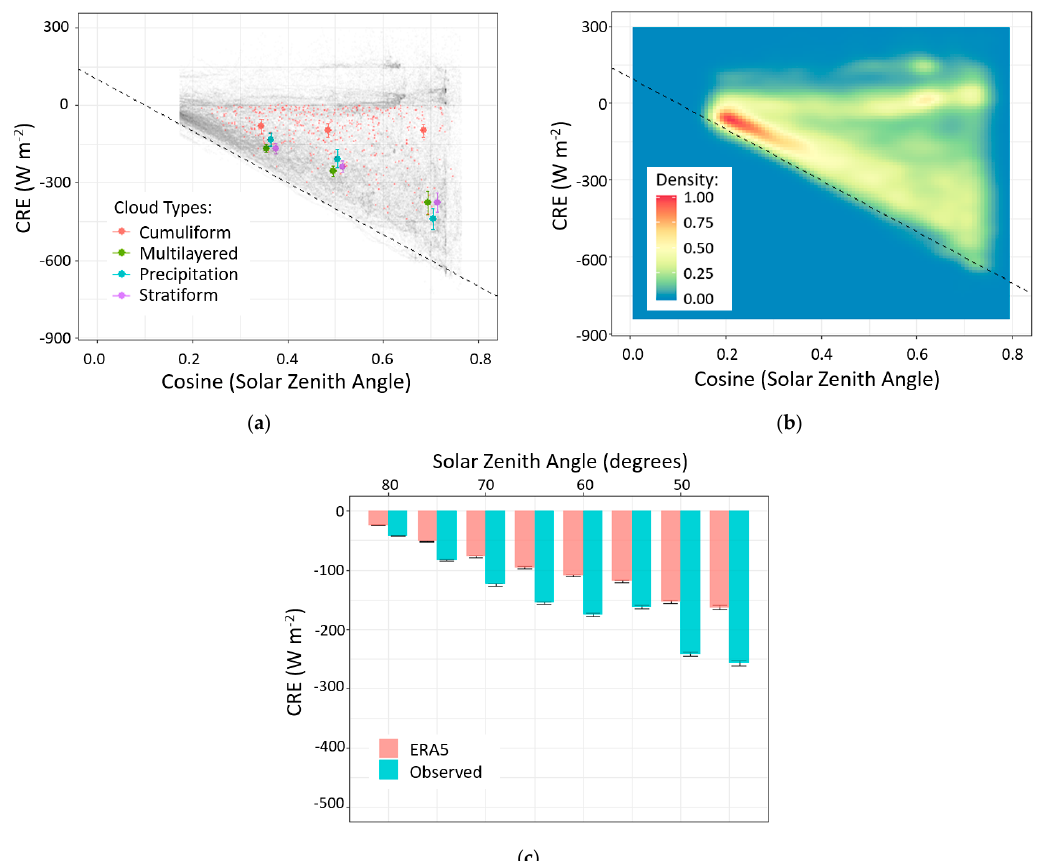
Figure 12. Net cloud radiative effect (CRE) from all observations as a function of the cosine of solar zenith angle as ( a ) individual points (grey filled dots) and ( b ) coloured by occurrence frequency (density) scaled to 0–1 (blue to yellow to red). In ( a ) small red filled dots show 3-hourly average values from ERA5; large filled dots are averages coloured according to cloud type inferred from camera images at three solar zenith angle: 69°, 60° and 46° (values are offset either side of the centre of each angle for clarity; vertical bars span ±2 standard errors in the mean): cumuliform clouds (orange), multilayered clouds (green), clouds causing surface precipitation (blue), and stratiform clouds (purple). In ( a ) and ( b ) the dashed line shows the approximate lower limit of measured net CRE from Minnett [54] . The observed 1-min CRE values are shown in half-transparent grey dots and 3-hourly averaged ERA5 data (red dots). ( c ) Histograms of averaged net CRE as a function of solar zenith angle from all 1-min observations (blue) and averaged net CRE from 1-min interpolated ERA5 data (red). The vertical bars span ±2 standard errors in the mean.